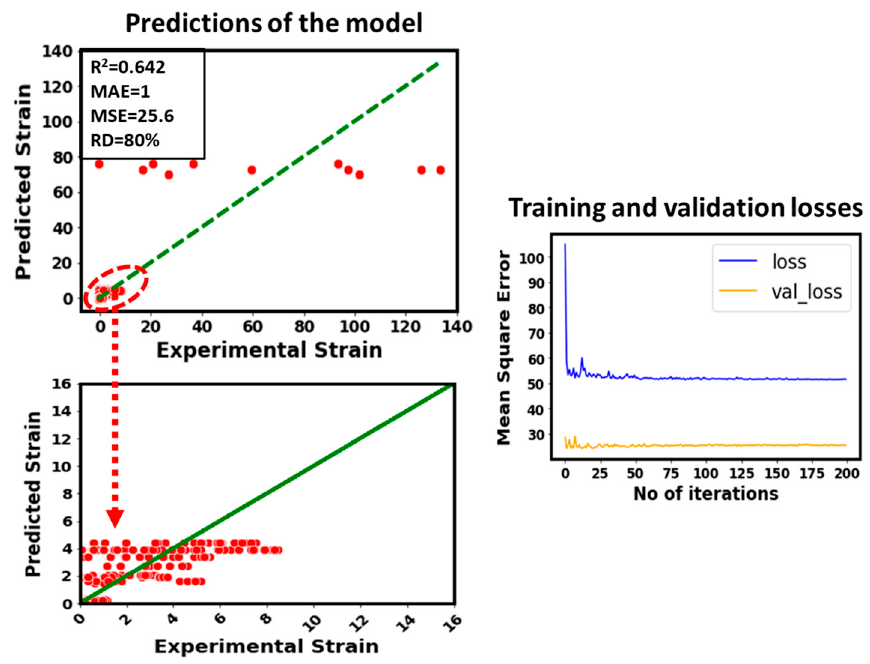
Figure 7. Predictive performance of the developed model by removing stress from the inputs.